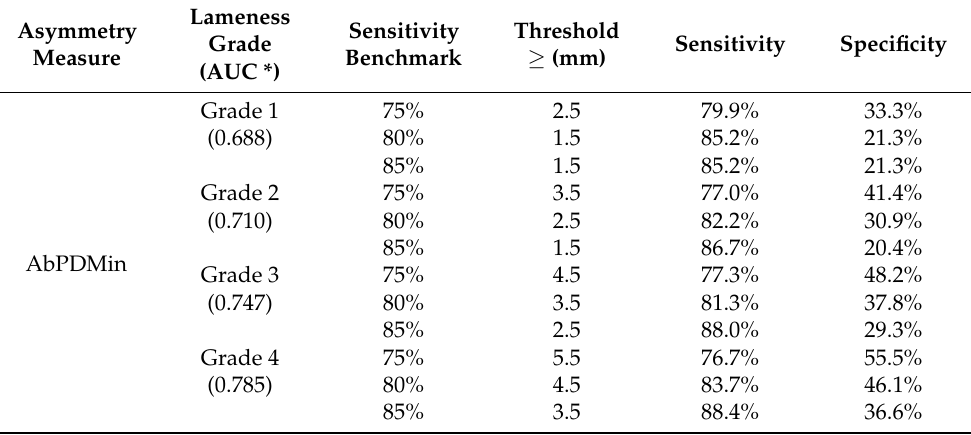
Table 3. Minimum threshold values for identifying horses in the specific lameness grade (or higher) under set minimum sensitivity benchmarks of 75, 80 and